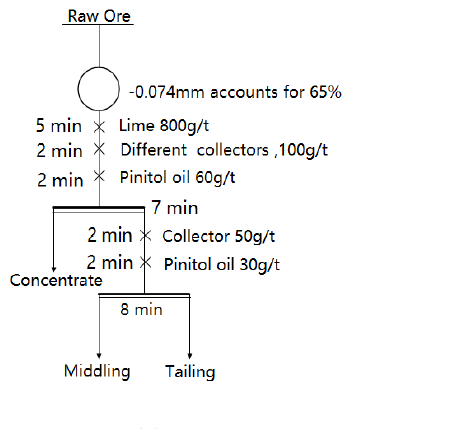
Figure 7. Effect of collector type on the recovery of sulfide aggregates. ( a ) The flow chart for flotation experiments ( b ) The result for flotation experiments.